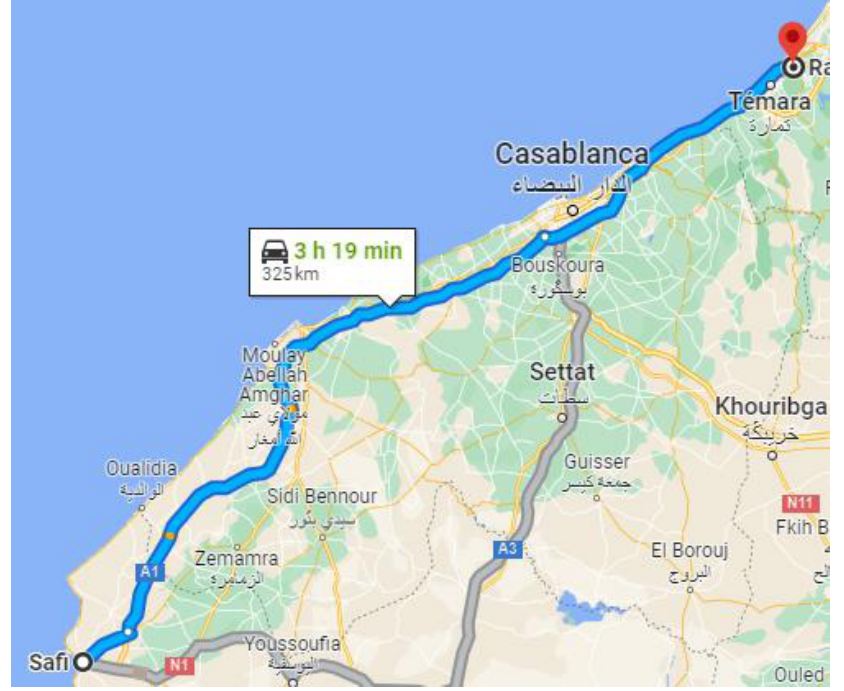
Figure 2. The itinerary between Safi and Rabat